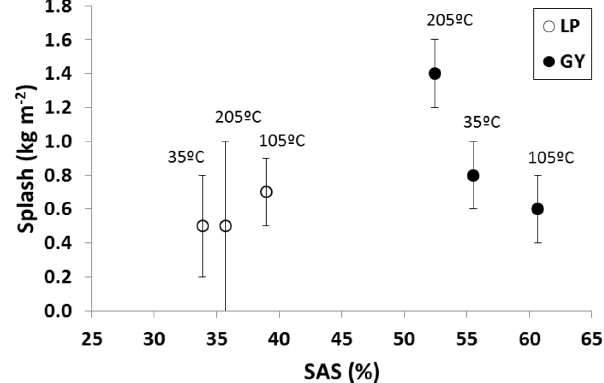
Fig. 5. Relationship between soil aggregate stability and splash ero- sion in both soils (means and standard deviations).